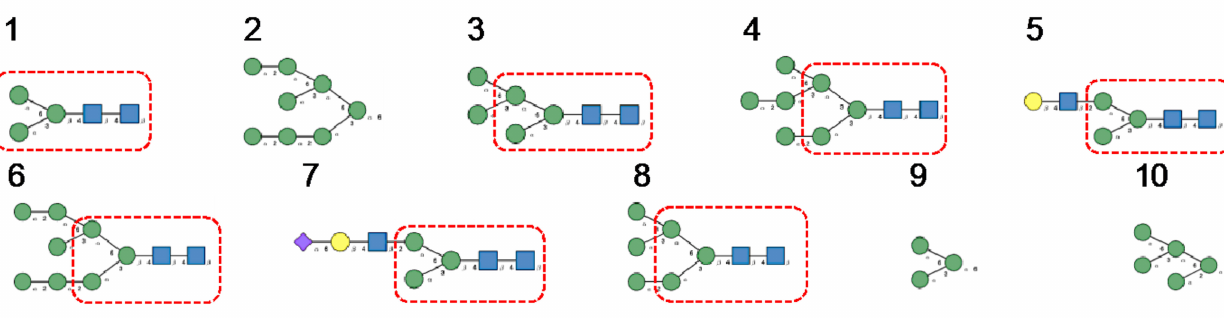
Figure 9. Glycans recognized by GNA in glycan array experiments, arranged from 1 to 10 in decreasing order of affinity. Results obtained with Morniga-M, a typical representative of the jacalin-related Man- binding lectins, reveal some reactivity towards bisected hybrid glycans (Figure 10):